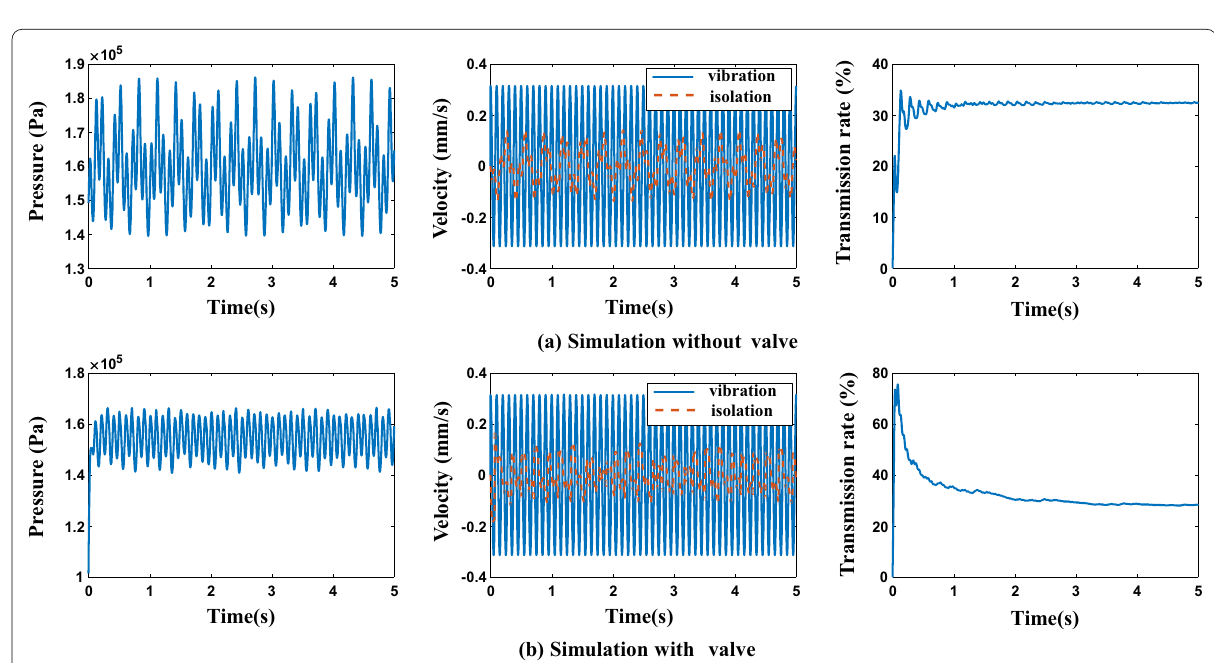
Figure 8 Simulation results comparison of pressure, velocity and transmission rate under 10 Hz